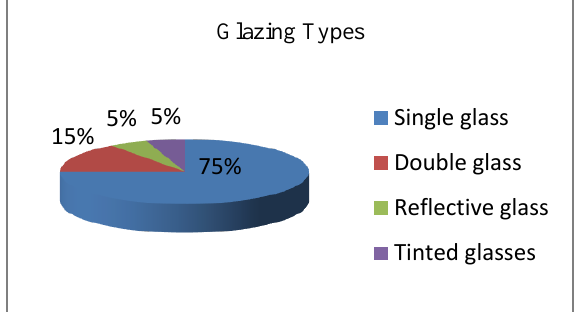
Figure 6. The above pie chart shows the different glazing types in Karakol residential